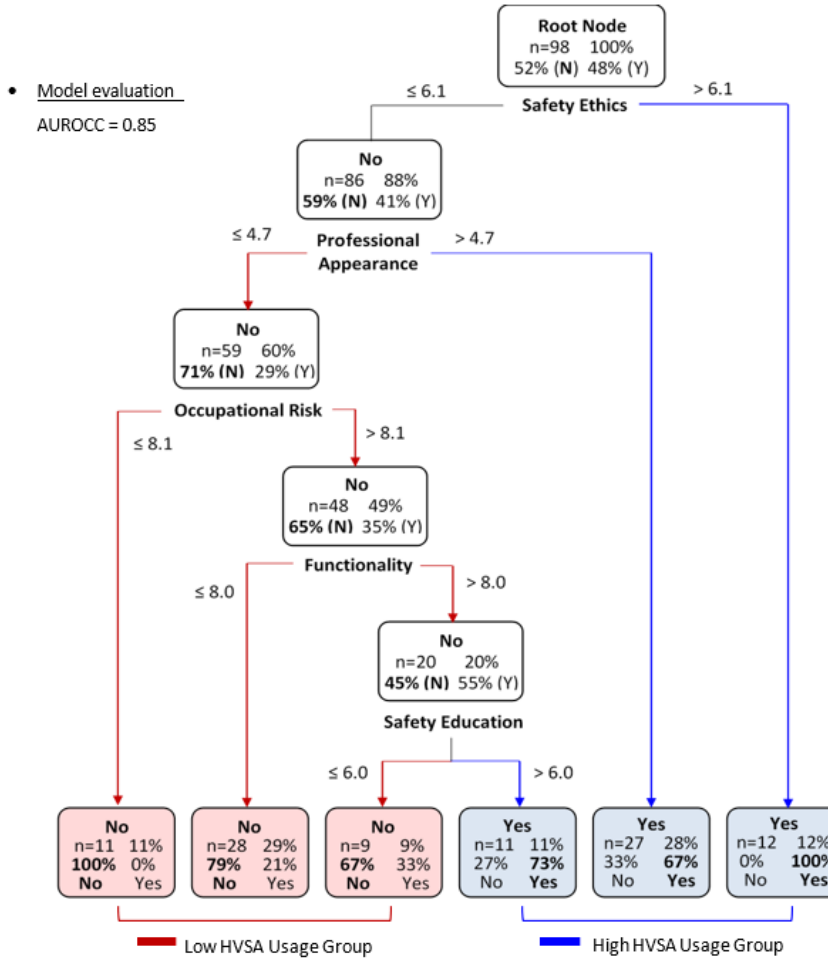
Figure 2. Decision tree model.